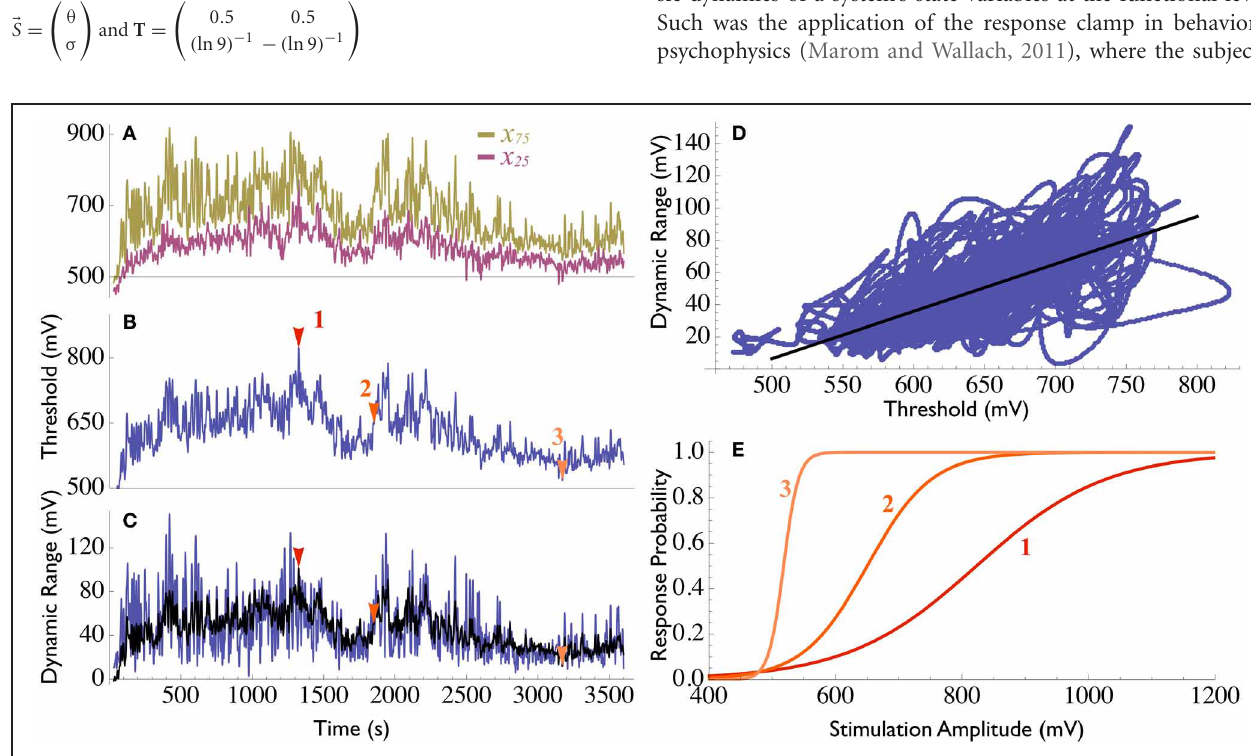
[Equation 5, black line in panel (D) , R 2 = 0 . 52] enables the estimation of the dynamic range based on the instantaneous threshold [black line in panel (C) ]. (E) Examples to the instantaneous I/O relations (Equation 6) at three different points in time [marked with colored arrowheads in panels (B) and (C) ]. The curve becomes stretched as the threshold increases. Note that as the threshold approaches the minimal value θ 0 , the curve approaches a step-function, i.e., the neuron becomes a deterministic